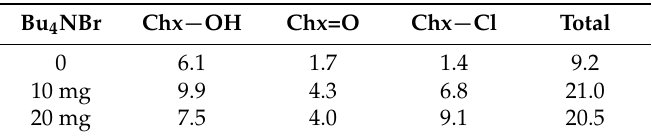
Table 2. Yield (µmol) of photolysis products after 20-min irradiation (100 W Hg lamp, λ > 360 nm) of